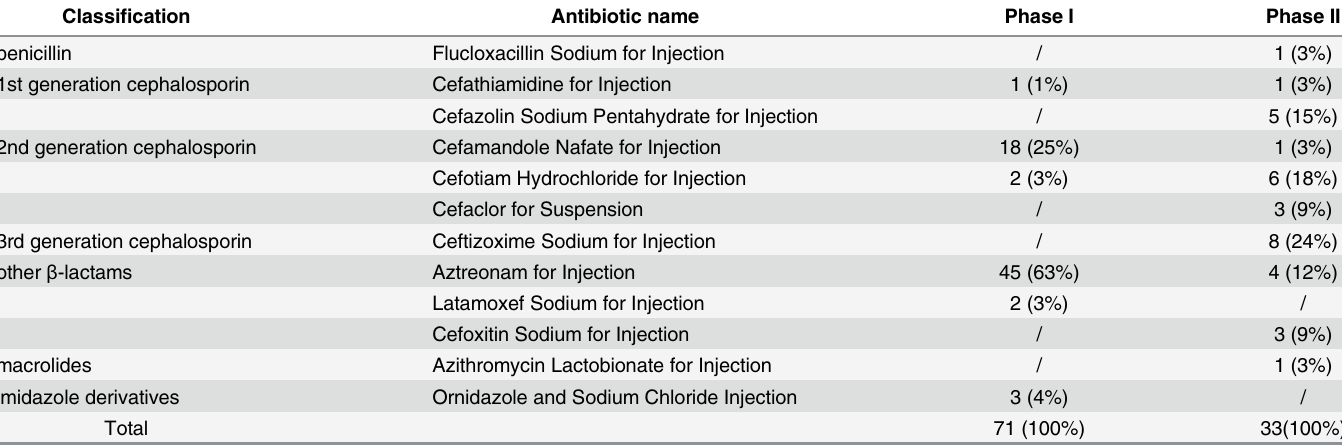
Table 2. Prescription quantity of antibiotics used to 97 children with intussusception